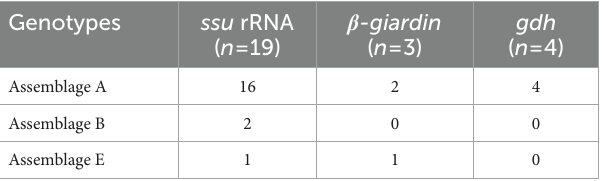
TABLE 2 Genotyping of Giardia duodenalis based on 18S rRNA, β -giardin , and gdh amplification.